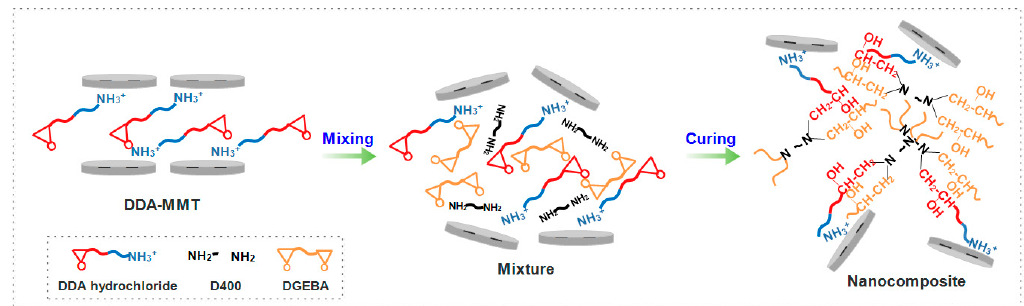
Figure 8. Schematic representation of the preparation process of DDA-MMT/DGEBA nanocomposite.